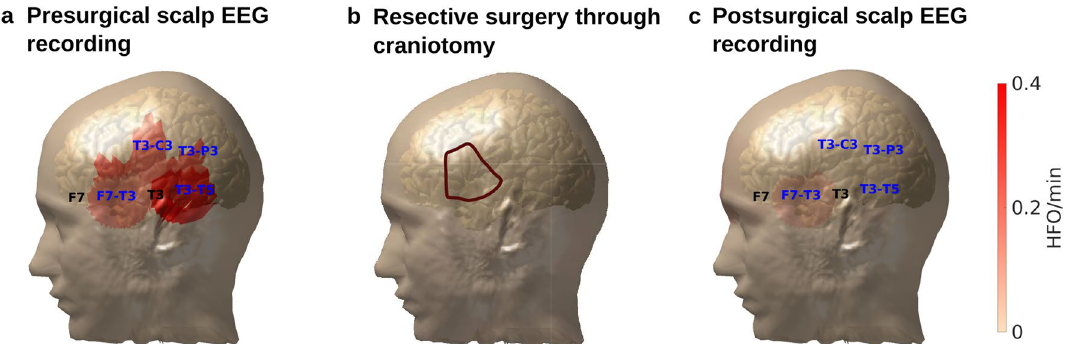
Figure 2. Scalp HFO rate distribution in presurgical and postsurgical EEG in relation to the skull defect resulting from craniotomy. 3D reconstruction of the skull and the cortical surface generated using the presurgical and postsurgical MRI of patient 12, who had a left temporal ganglioglioma. The spatial distribution of HFO rates in presurgical and postsurgical EEG is depicted using areas marked with different shades of red. Different color intensity corresponds to different HFO rates. HFO area channels are shown in blue, skull defect electrodes in black . ( a ) In the presurgical scalp EEG, high HFO rates were measured in left temporal channels, matching the location of the HFO area, the epileptogenic zone, and the lesion in the anterior portion of the fusiform gyrus. ( b ) Given the lesion location, a pterional craniotomy approach (outlined in brown) was chosen to fully resect the epileptogenic zone and lesion. ( c ) In the postsurgical EEG, HFO rates drastically decreased, in line with postsurgical seizure